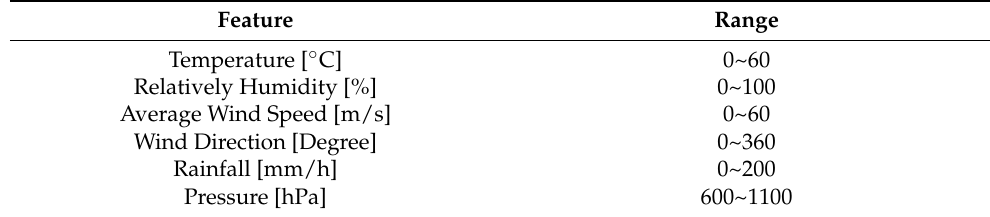
Table 2. Local weather sensor specification sheet.